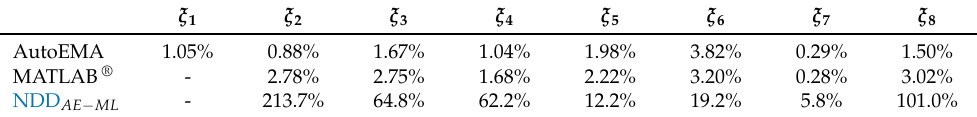
Table 9. Comparison of modal damping ratios ξ i found by MATLAB ® and AutoEMA for WPT position z 2 ; "-" indicates that no matching mode with a MAC value of at least 80% was found. ξ 1